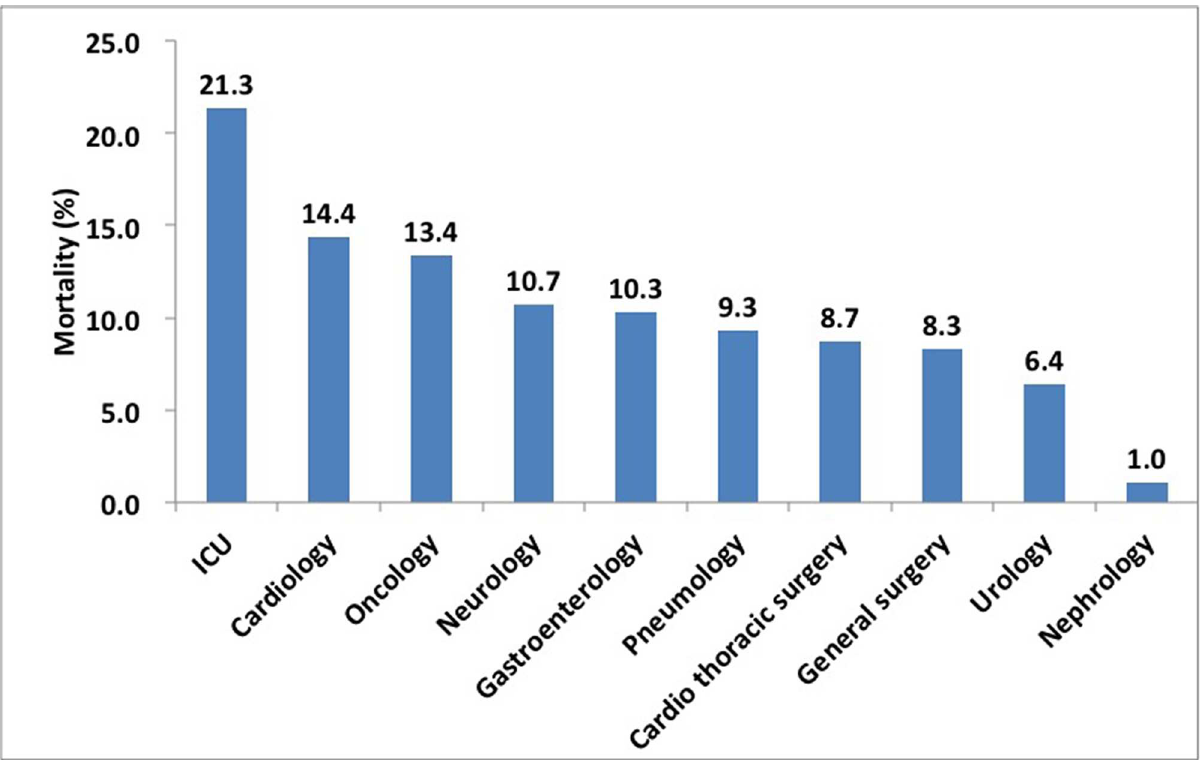
Fig 2. Mortality of AKI in different clinical